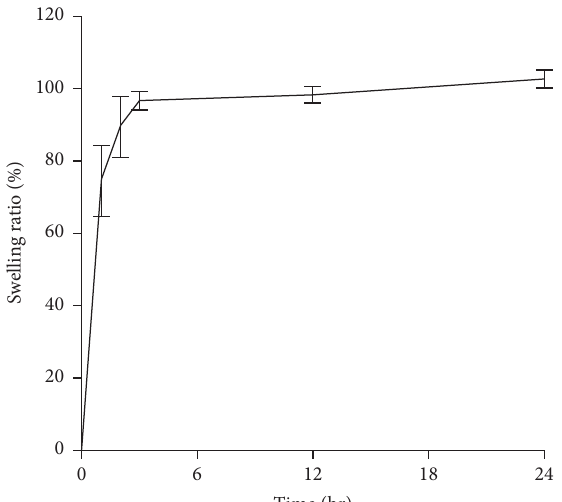
Figure 8: Swelling ratio or water uptake capacity of DFS scafold. Te water uptake capacity was determined by the amount of PBS solution absorbed by the scafold per hour in a pH and temperature-maintained condition. Error bars are the standard deviation from triplicate